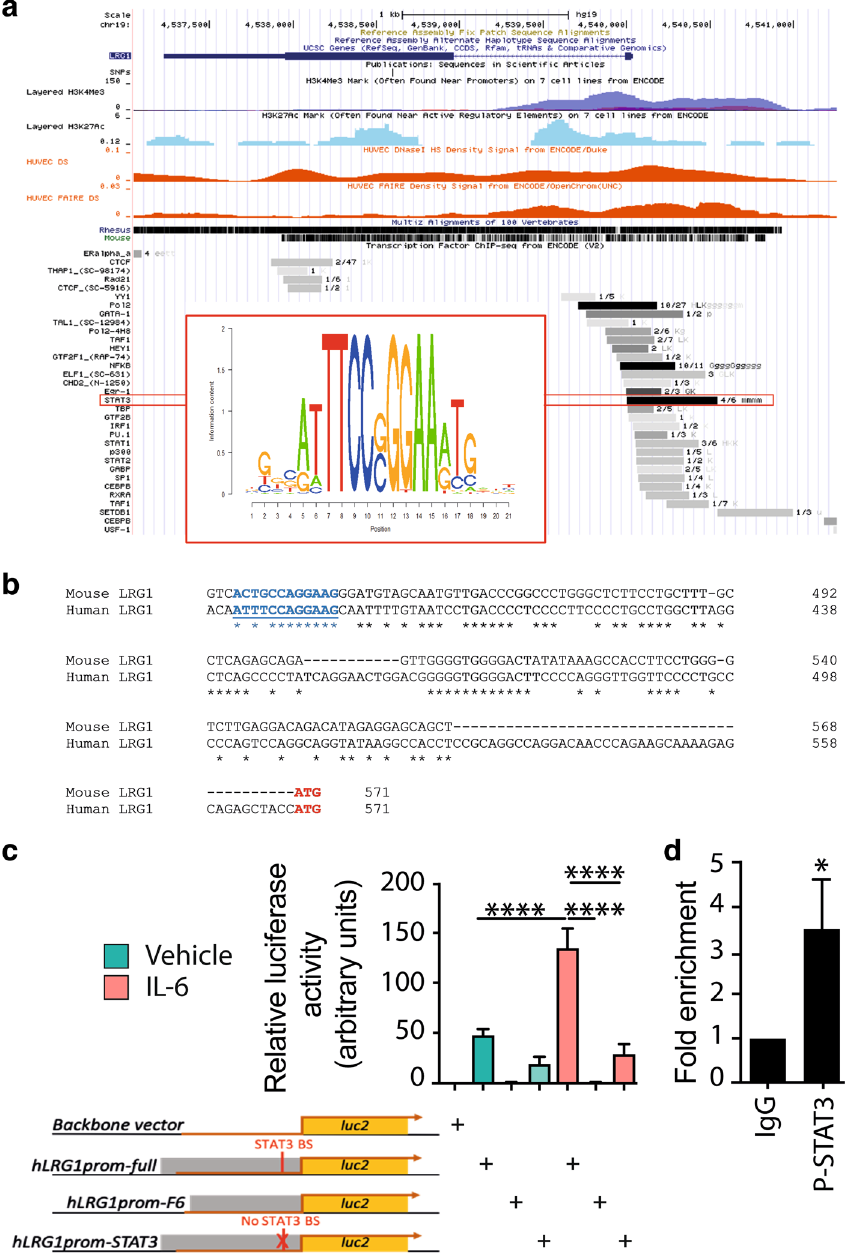
Figure 4. IL-6 activates LRG1 gene transcription. ( a ) In-silico analysis of the human LRG1 gene promoter showing transcription factor binding predictions, including the STAT3 consensus binding site (UCSC genome browser). ( b ) Nucleotide alignment (ClustalW) of the mouse and human LRG1 gene promoters. The STAT3 consensus binding site is underlined and highlighted in blue, and the translation initiation site is highlighted in red. ( c ) Luciferase reporter assays performed in HepG2 cells stimulated with PBS as control/vehicle or 50 ng/ml IL-6 and transfected with luciferase plasmids. Backbone vector: pGL4.10 plasmid, hLRG1prom-full: pGL4.10 with the full-length human LRG1 promoter driving expression of the luciferase ( luc2 ) gene, hLRG1prom-F6: hLRG1prom-full without 200 bp surrounding the STAT3 binding site, hLRG1prom-STAT3, hLRG1prom-full without 54 bp surrounding the STAT3 binding site. ANOVA with multiple comparisons test (Tukey’s), ( d ) Chromatin immunoprecipitation (ChIP) assays performed in HepG2 cells stimulated with 50 ng/ml IL-6 for 16 h. An anti-P-STAT3 antibody (cs #9145) was used for the ChIP, and a normal rabbit IgG (cs #2729) was used as a negative control. Data are presented as fold enrichment to IgG (2^-ΔΔCt). Mann Whitney test. N ≥ 3 independent experiments. Mean ± SEM, * ≤ 0.05, **** ≤